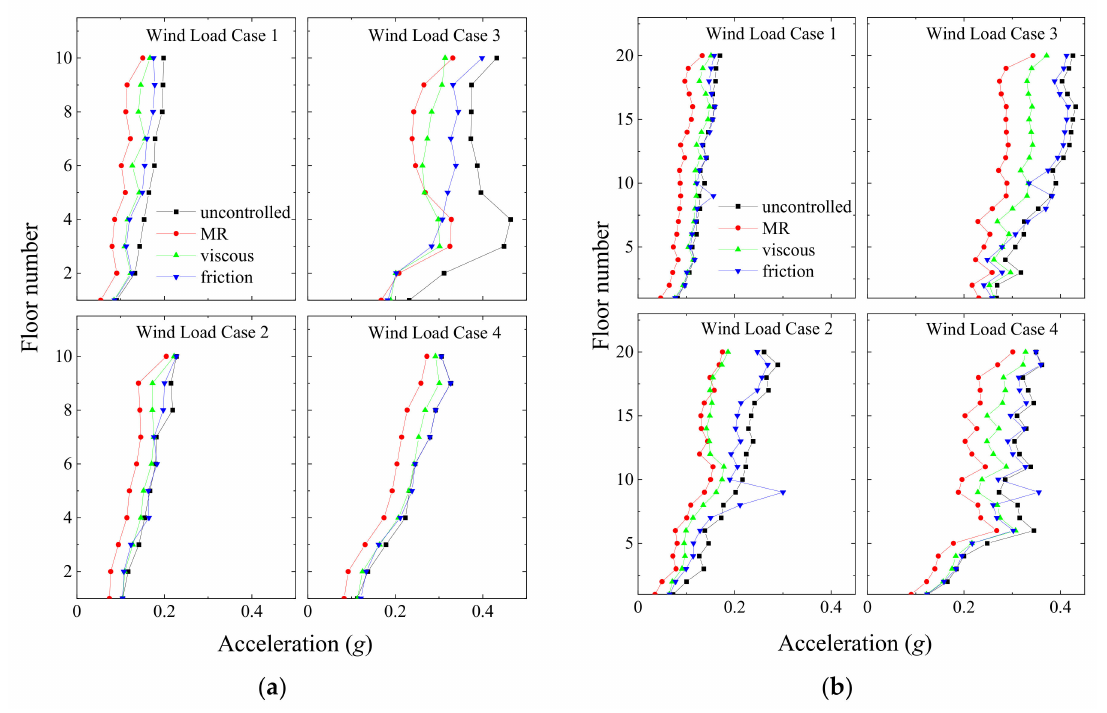
Figure 33. Peak floor acceleration response under wind excitation obtained from different dampers in: ( a ) a coupled stiff building and ( b ) a coupled flexible building when dampers are arranged in Configuration 1.